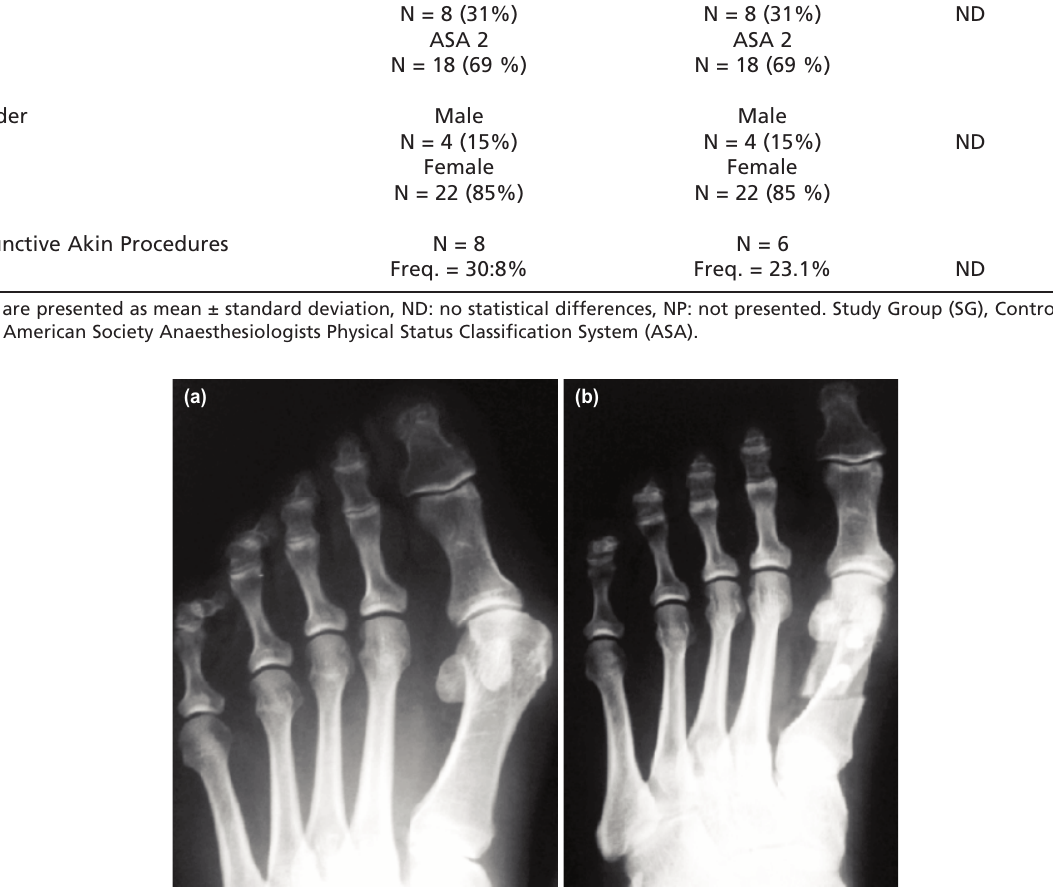
(a) The pre-surgery radiograph. (b) The post-surgery radiograph after performing a SCARF Fig. 1: